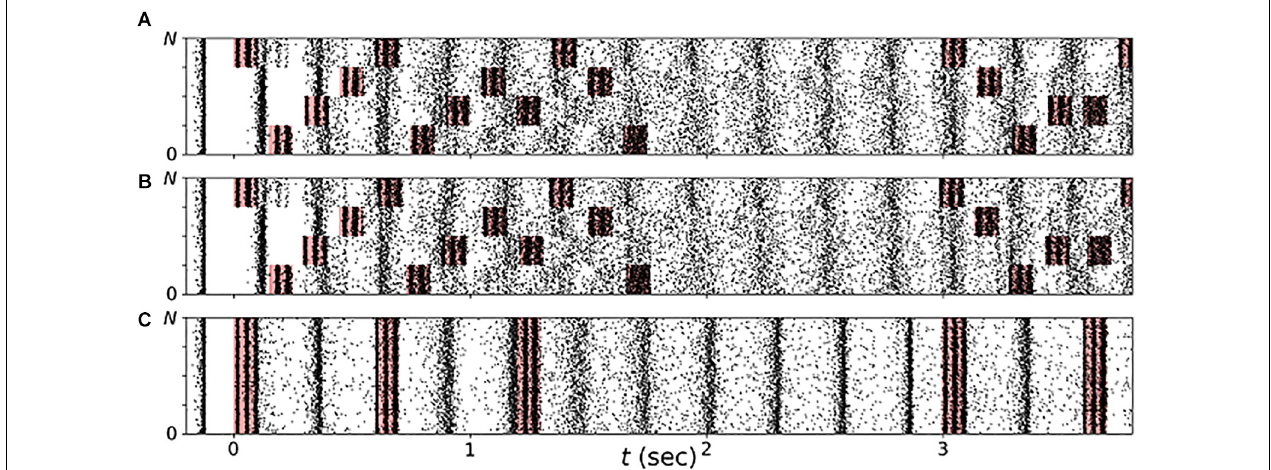
FIGURE 9 | Stimulation shapes neuronal spiking activity. Raster plots of neuronal spiking activity during the first few seconds of vibrotactile stimulation with a regular vibrotactile coordinated reset (vCR) pattern (A) , a noisy vCR pattern (same sequence as regular CR but with jitter of 23 . 5% ) (B) , and vibratory purely periodic multichannel stimulation (vPPMS) (C) . Sensory inputs caused by vibratory burst delivery to corresponding fingertips are marked red. Parameters: t = 0 marks onset of stimulation with f CR = 1 . 67 Hz and A = A 0